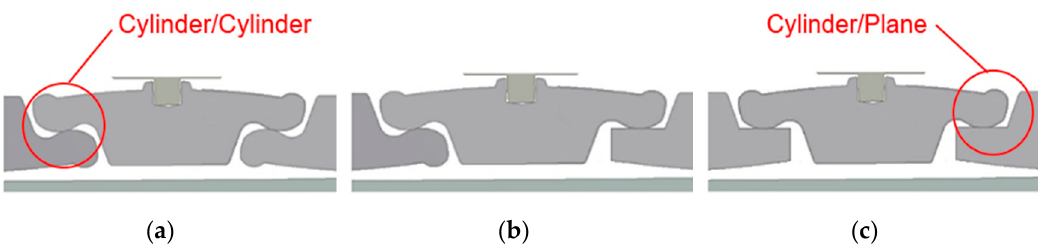
Figure 5. Variants of contact surfaces of lever, ( a ) Cylinder/Cylinder contacts on both sides of a lever, ( b ) Cylinder/Cylinder contact on the left side and Cylinder/Plane contact on the right side, ( c ) Cylinder/Plane contacts on both sides of a lever.